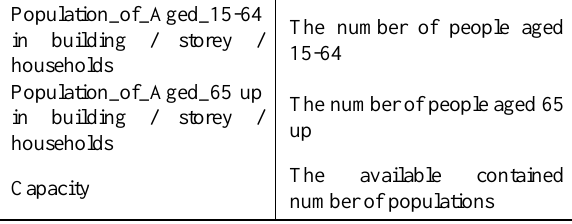
Table 1. Attribute information of hierarchy representation